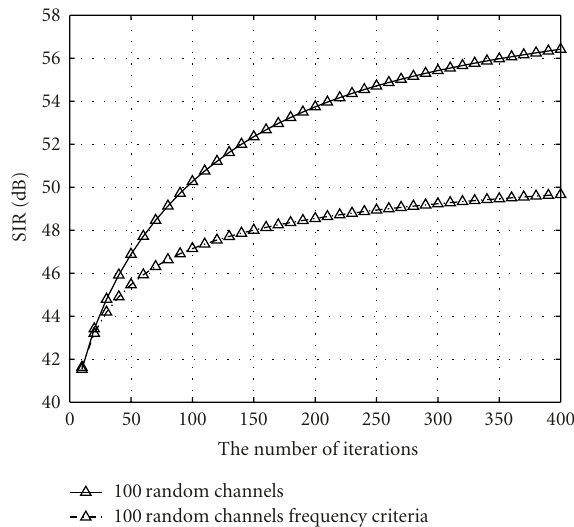
Figure 5: SIR versus the number of